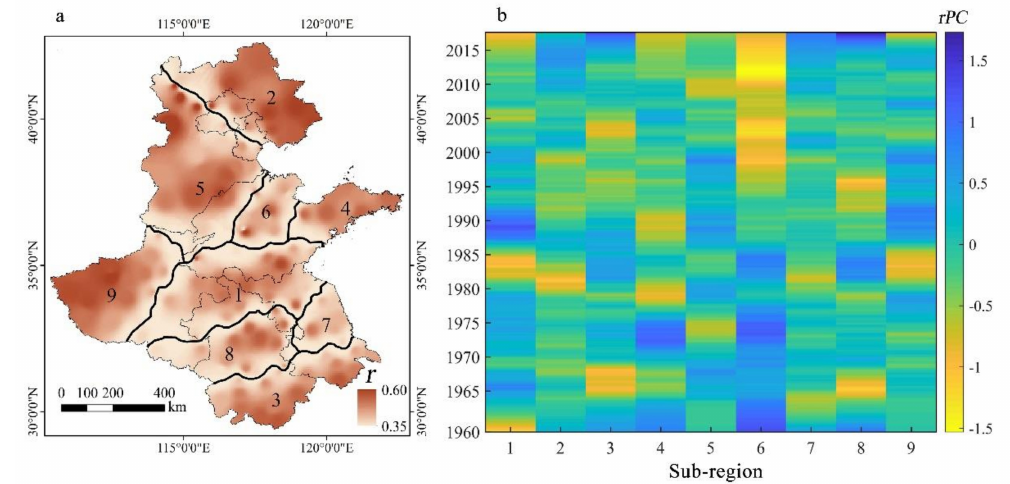
Figure 4. Sub-regions recognized in the North China Plain for fall drought variability ( a ) and the standardized rotated principal component (rPC) time series for sub-regions in fall ( b ). Each sub-region in ( a ) has a number that corresponds to its rPC time series in ( b ),